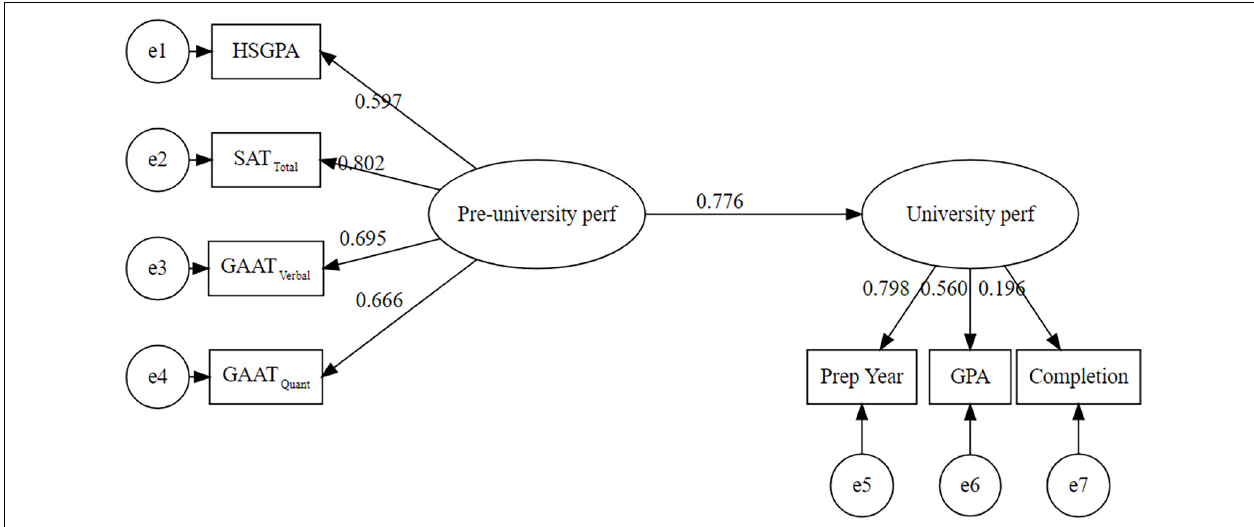
FIGURE 1 | Path coefficients of the relationship between pre-university measures and university performance.